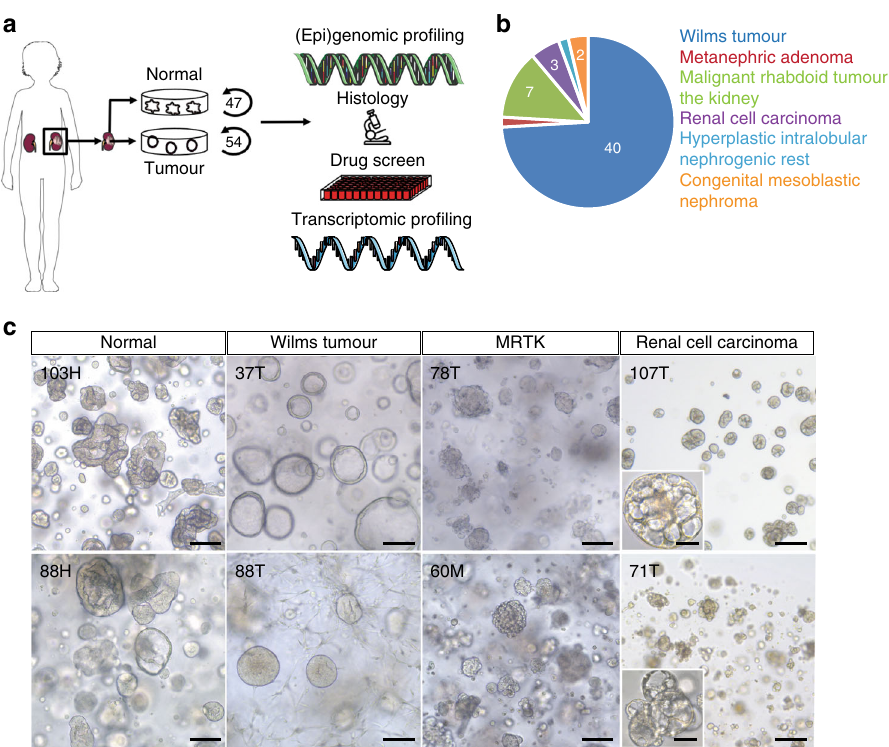
Fig. 1 Establishment of a biobank of paediatric kidney cancer organoids. a Overview of the procedure to generate and characterise paediatric kidney cancer organoids. Organoids were established from tumour and, if available, matching normal kidney tissue. Organoids were subsequently characterised using histology, whole-genome sequencing (WGS), RNA sequencing (RNA-seq) and DNA methylation pro fi ling. Lastly, drug screens were performed on a subset of Wilms tumour organoids. Modi fi ed from Servier Medical Art, licensed under a Creative Common Attribution 3.0 Generic License. b Pie chart representing the composition of the paediatric kidney cancer organoid biobank, consisting of organoids derived from Wilms tumours, MRTKs, RCCs, nephrogenic rests, metanephric adenoma and congenital mesoblastic nephromas. Clinical characteristics can be found in Supplementary Table 1. c Representative bright fi eld microscopy images of normal kidney tissue-derived organoids, Wilms tumour organoids, MRTK organoids and RCC organoids ( n = 3). H healthy, T primary tumour, M metastasis. Scale bar: 100 µ m, zoom in 20 µ